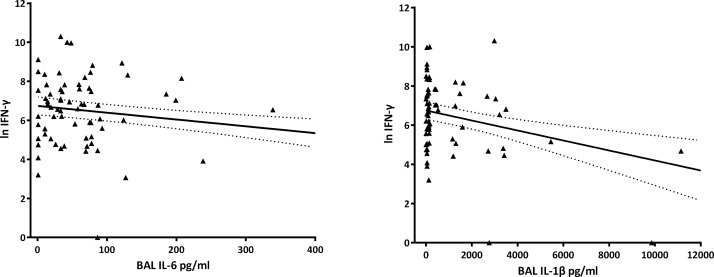
Shows the univariate regression model of NTHi-driven IFN-γ production by blood mononuclear cells and IL-1β a) and IL-6 b) concentration in the bronchoalveolar lavage fluid.As the multivariate analyses showed that only IL-1γ and IL-6 were independently associated with the capacity for NTHi-driven IFN-γ production, other BAL mediators are not shown in the figure.